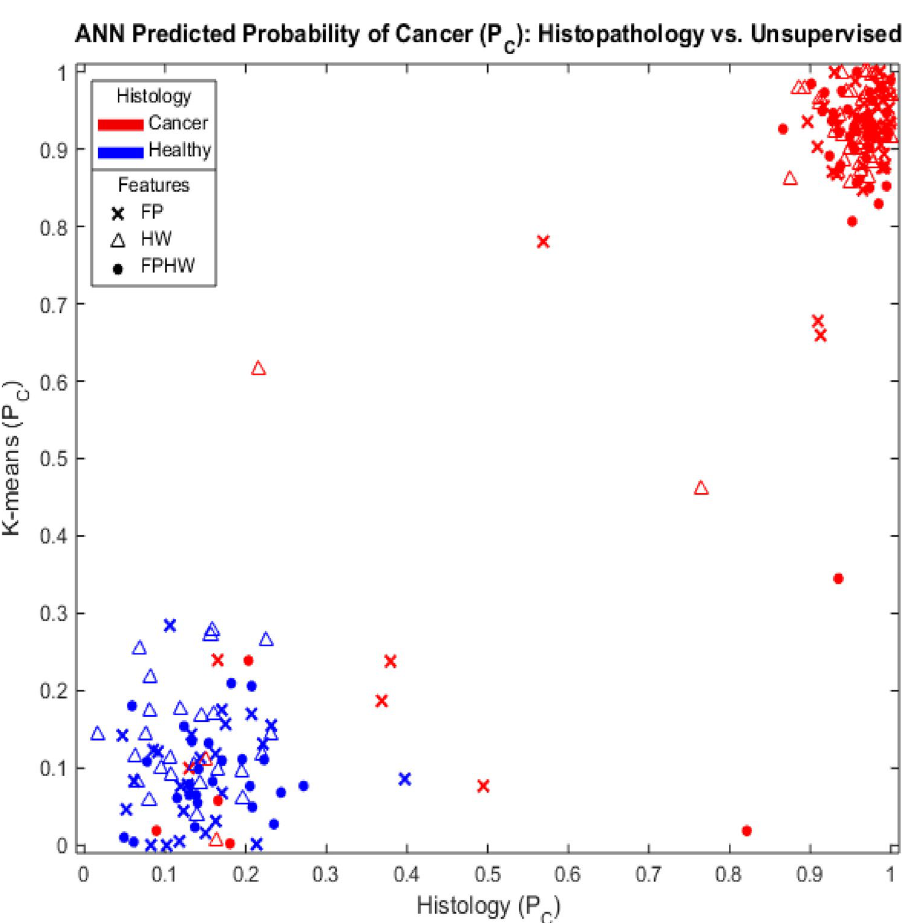
Figure 3. Bayesian probabilistic classification for 74 spectra from 5 patients using either H&E staining (x-axis) or k-means unsupervised spectral clustering (y-axis) as training gold standard. Spectra were from regions classified by histopathology as likely to be composed of either 100% or 0% tumor. Networks were trained using as inputs (x) 6 bands from the FP region (FP); ( △ ) 3 bands from the HW region (HW); or ( bands (FPHW). Targets obtained from tissue in tumor-rich regions according to H&E stain are denoted by red markers, while data obtained from areas apparently devoid of tumor are denoted by blue